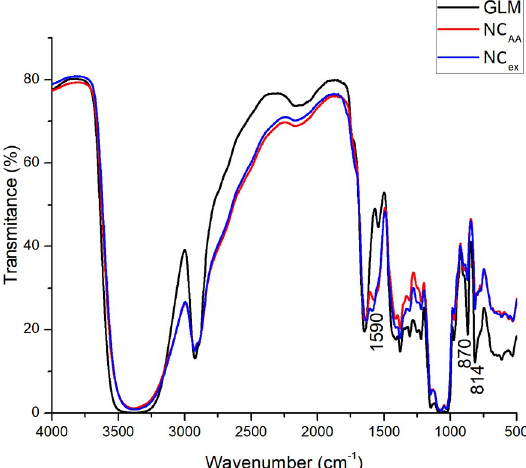
Figure 3. FTIR spectra for pure galactomannan (GLM) and the nanocomposites containing nanoparticles with encapsulated ascorbic acid (NC ) and acerola extract rich in vitamin C (NC AA